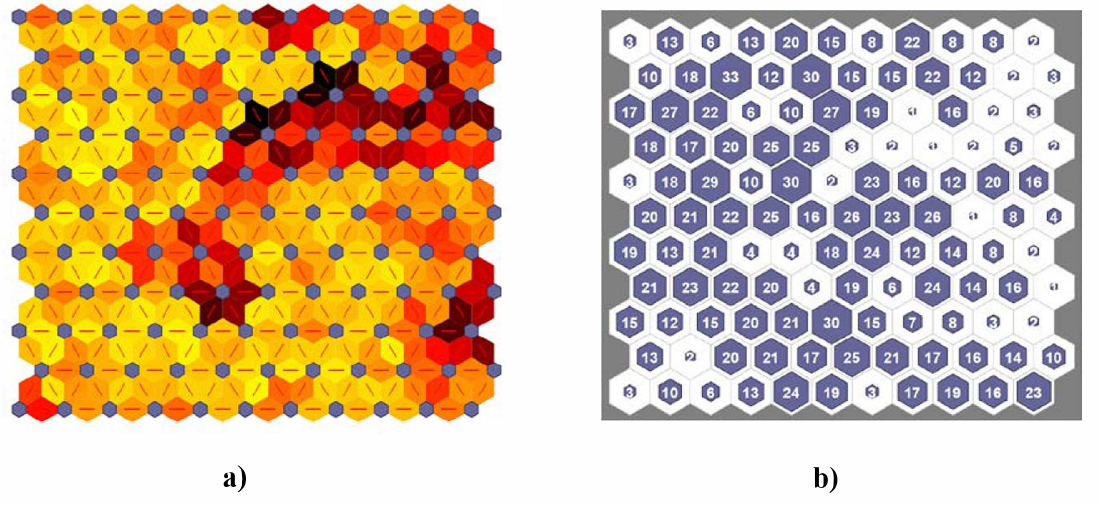
Figure 8. SOM organized into an 11 × 11 neuron grid. ( a ) Neighbor weight distances. The blue hexagons represent the output neurons, while the red lines are neuron connections. Darker colors represent larger distances between neighboring neurons, and lighter colors represent smaller ones. ( b ) Sample hits. This image shows how many training samples are associated with each